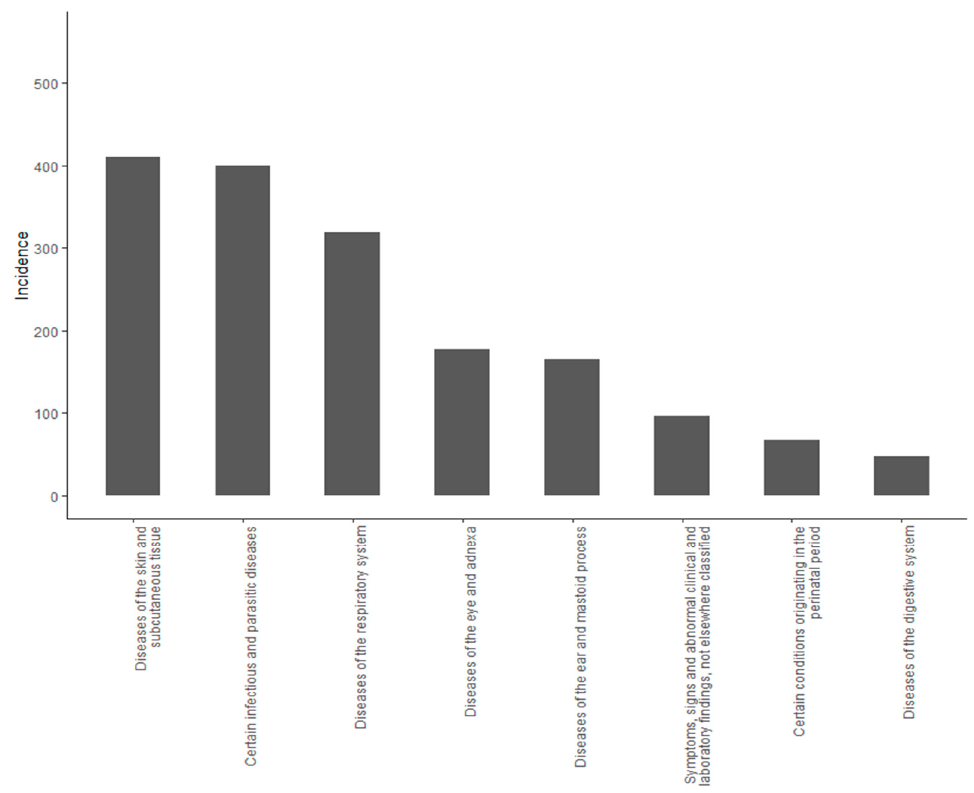
Figure 1. Incidence of disease. The incidence of the eight most common disease by ICD10-group among the 559 participants during the first three years of